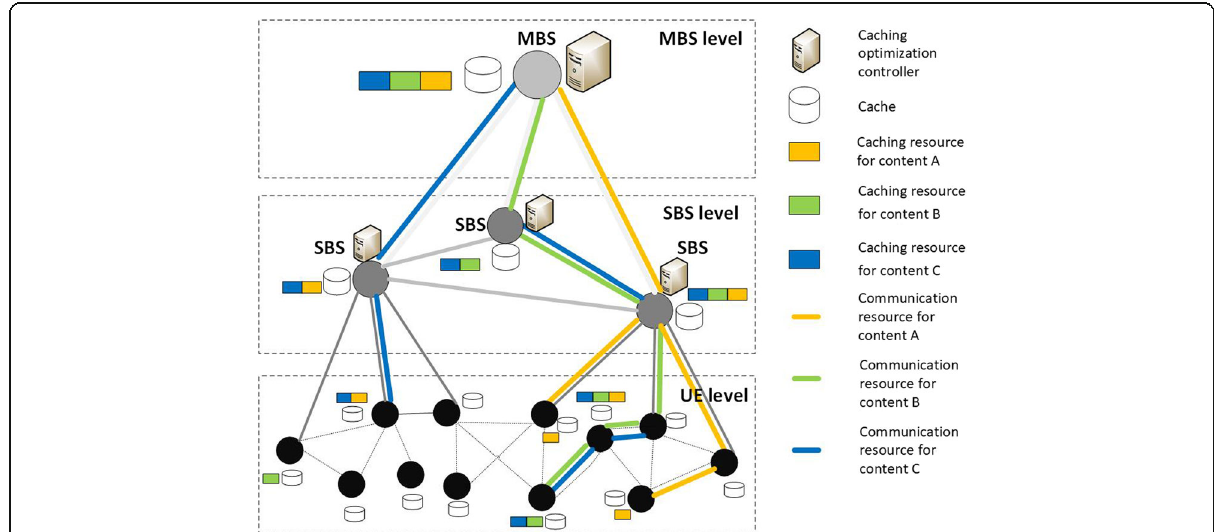
Fig. 2 Content-oriented network slicing in